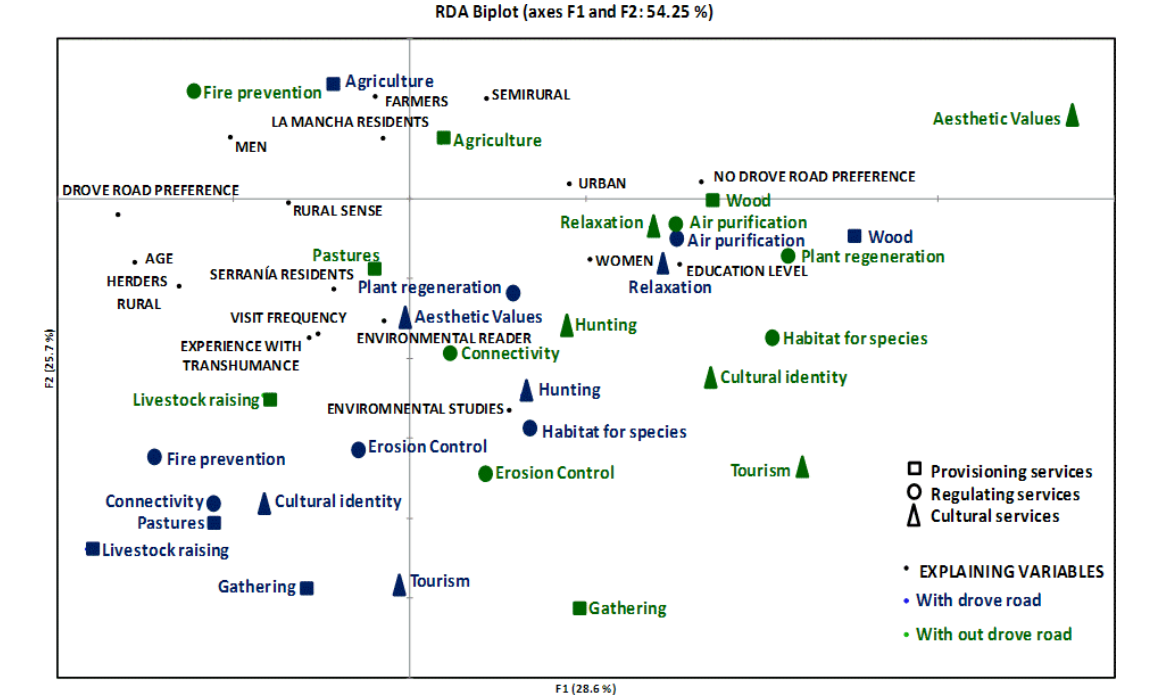
Fig. 4 . Biplot resulting from RDA (redundancy analysis) factors 1 (28.6% of variance explained) and 2 (25.7% of variance) for ecosystem services public appreciation in the pair of photographs depicting the Serranía de Cuenca pine forest. Ecosystems services suggested for the landscape picture with a drove road (Fig. 1B) are presented in blue, while the ecosystems services suggested for the landscape picture without a drove road (Fig. 1A) are presented in green. The ovals indicate the four groups of respondents